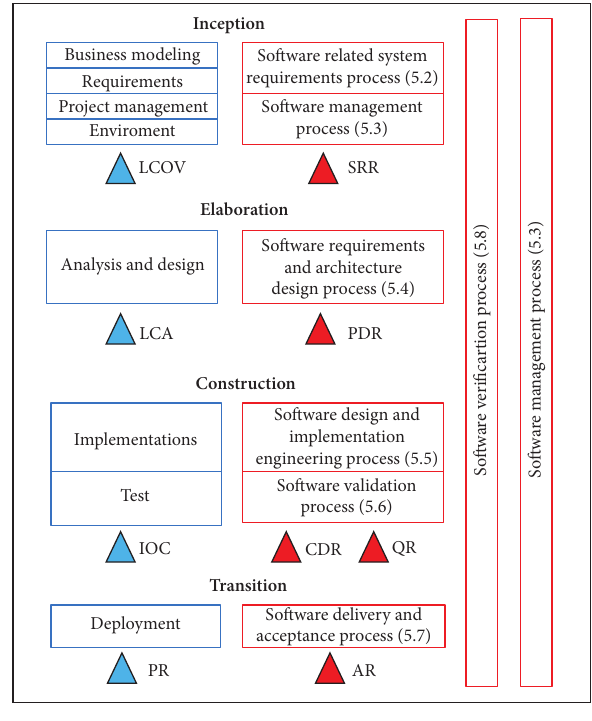
figure 6. H4ASD Life